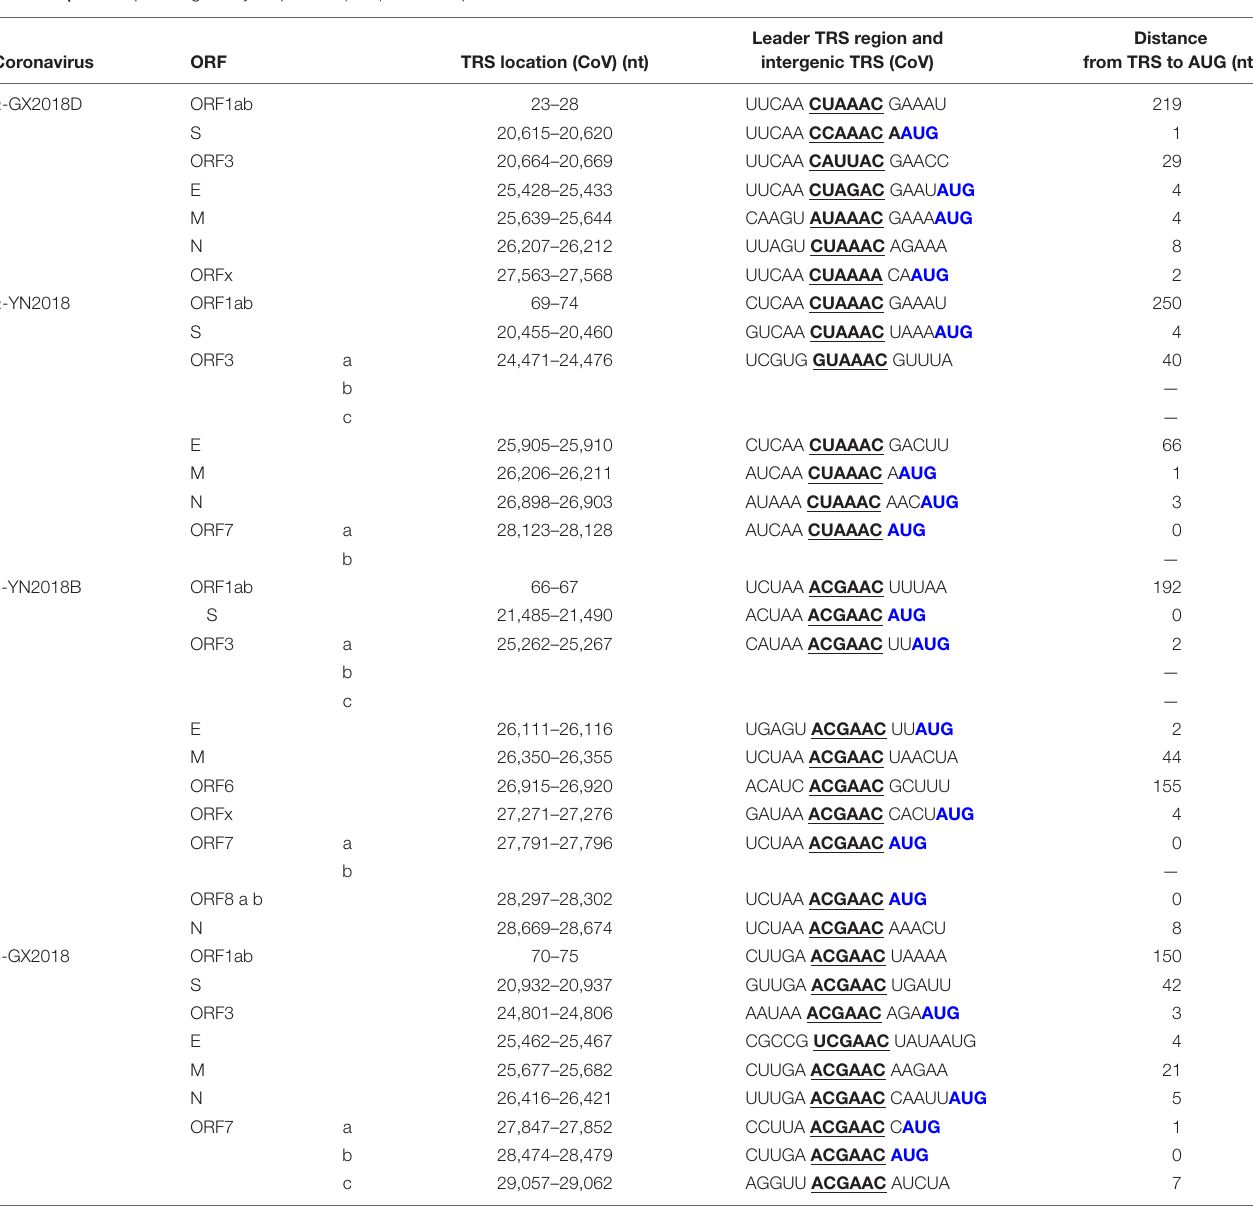
TABLE 3 | Transcription regulatory sequences (TRS) for four representative bat CoVs a , b . Leader TRS region and Distance Coronavirus intergenic TRS (CoV) from TRS to AUG